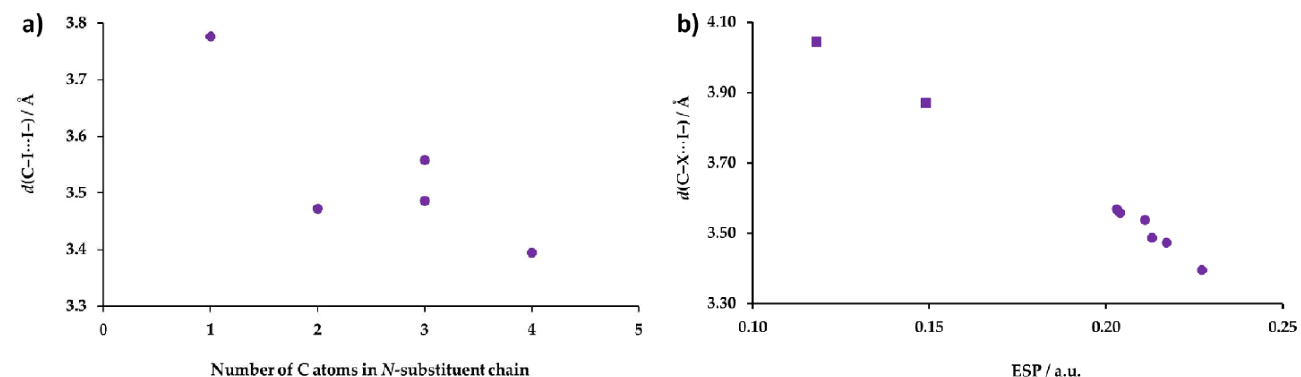
Figure 10. ( a ) Correlation of the number of carbon atoms in N -substituent chain of N -alkyl-3-iodipyridinium cations with